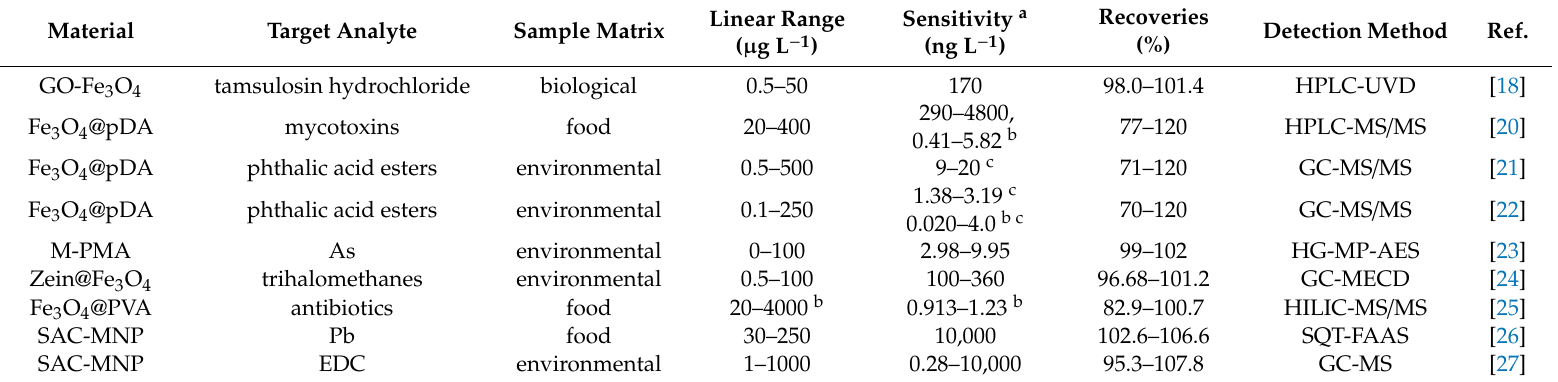
Table 2. Magnetic nanoparticle-based